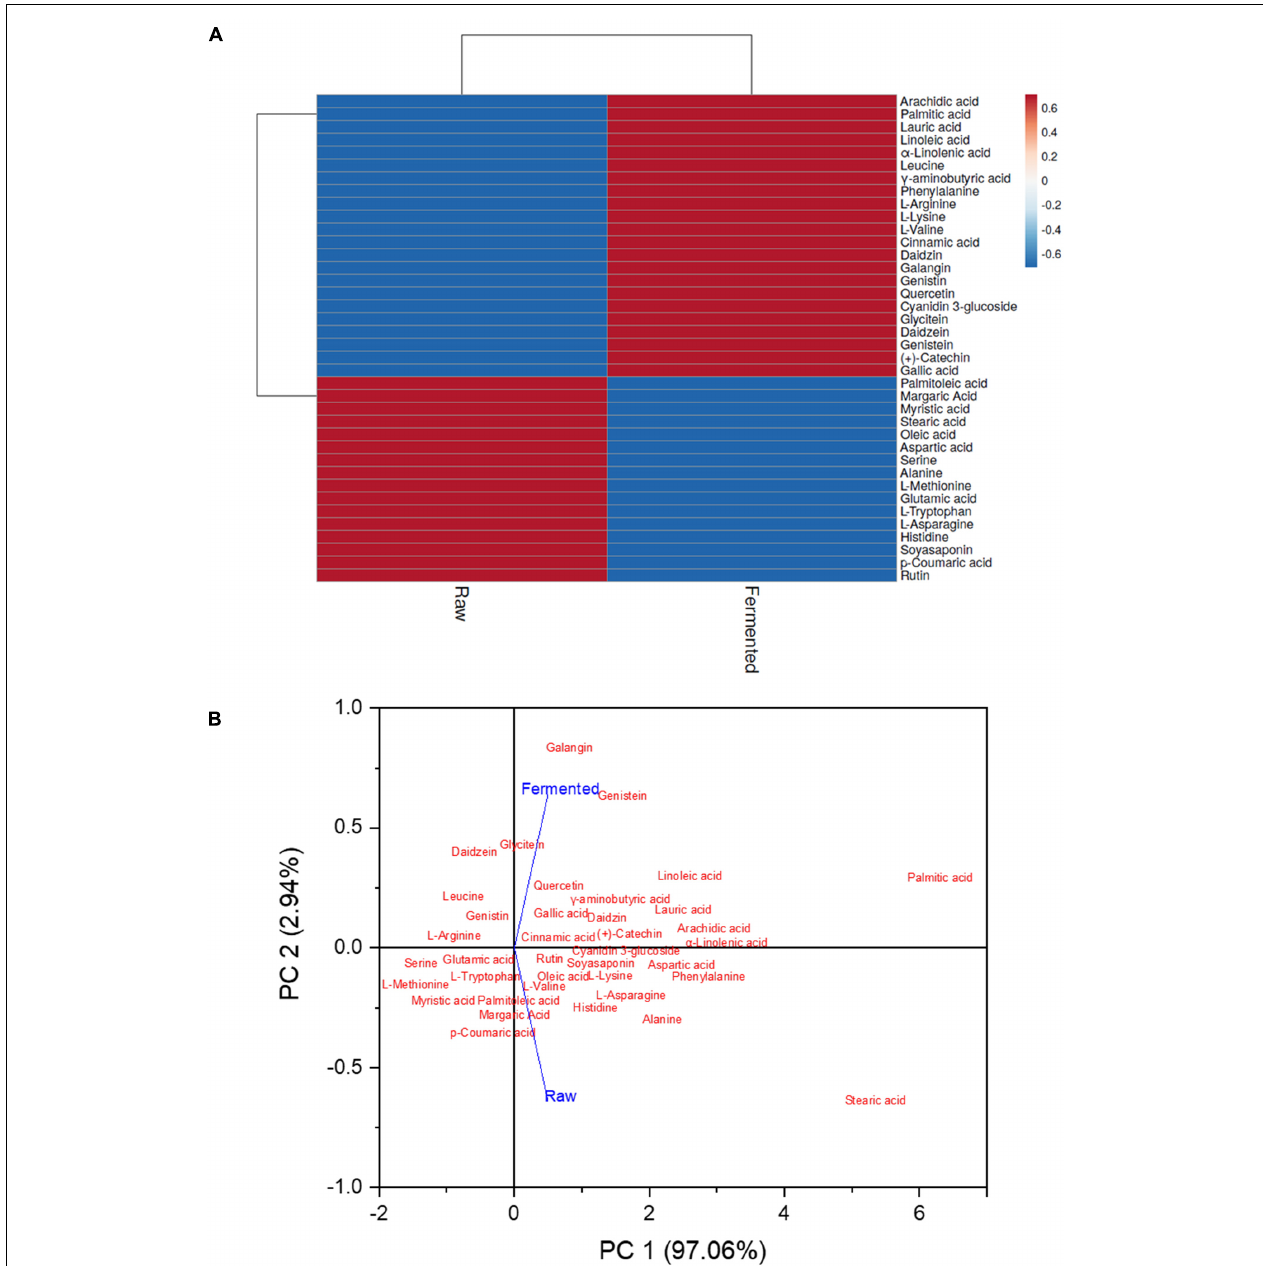
FIGURE 4 | Identified bioactive compounds in the raw and fermented black soybean. (A) Heat map exhibits the varying amounts of identified compounds, from blue to red in samples, reflecting an increasing trend. (B) Principle component analysis (PCA) of samples was shown by comparing PC1 with